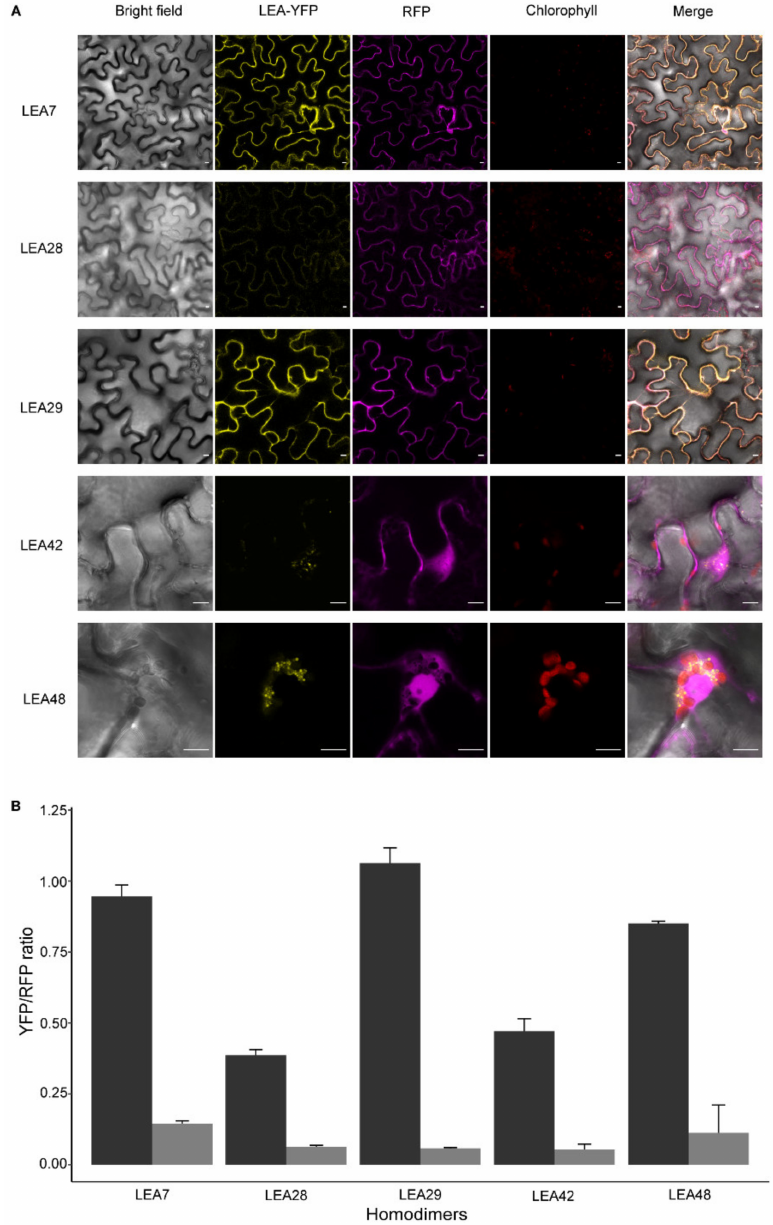
Figure 3. Homodimeric complex formation of LEA7, LEA28, LEA29, LEA42, and LEA48 in N. benthamiana leaves 4 d after infiltration. ( A ) Confocal microscope images. RFP channel is shown as reference marker. Bars indicate 10 µ m. ( B ) Relative mean of LEA-YFP fluorescence normalized with the RFP reference marker ( n = 15–25). Error bars show standard error. Black represents the interactions of each LEA protein while grey represents its negative